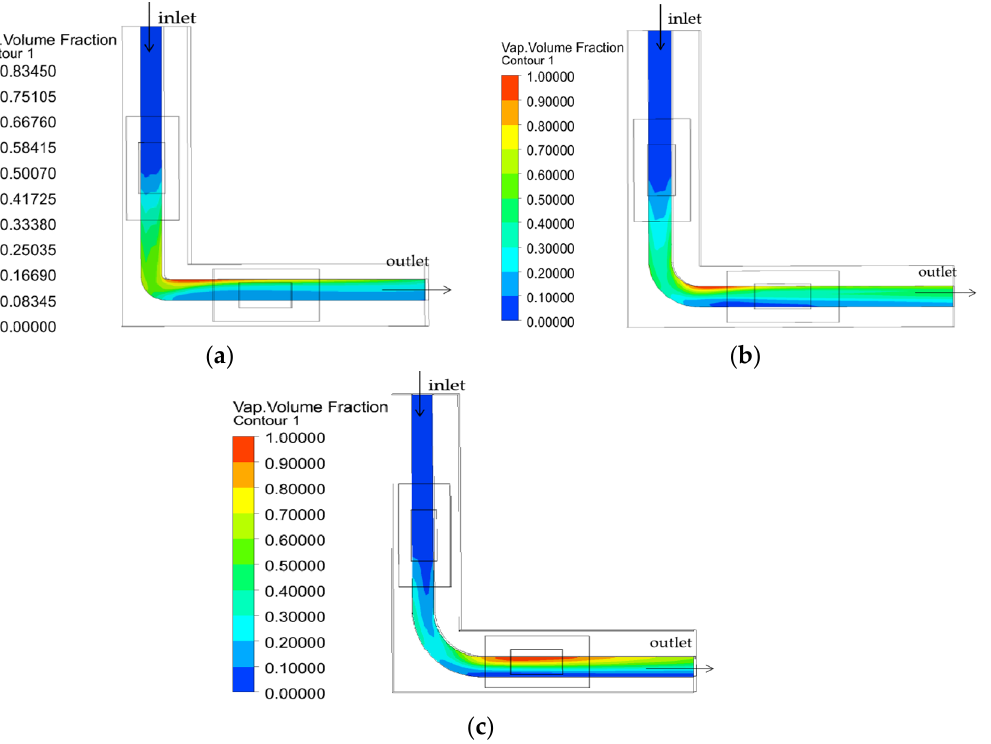
Figure 13. Vapor − phase distribution. The radius of each model is ( a ) 5 mm; ( b ) 9 mm; ( c ) 13 mm.